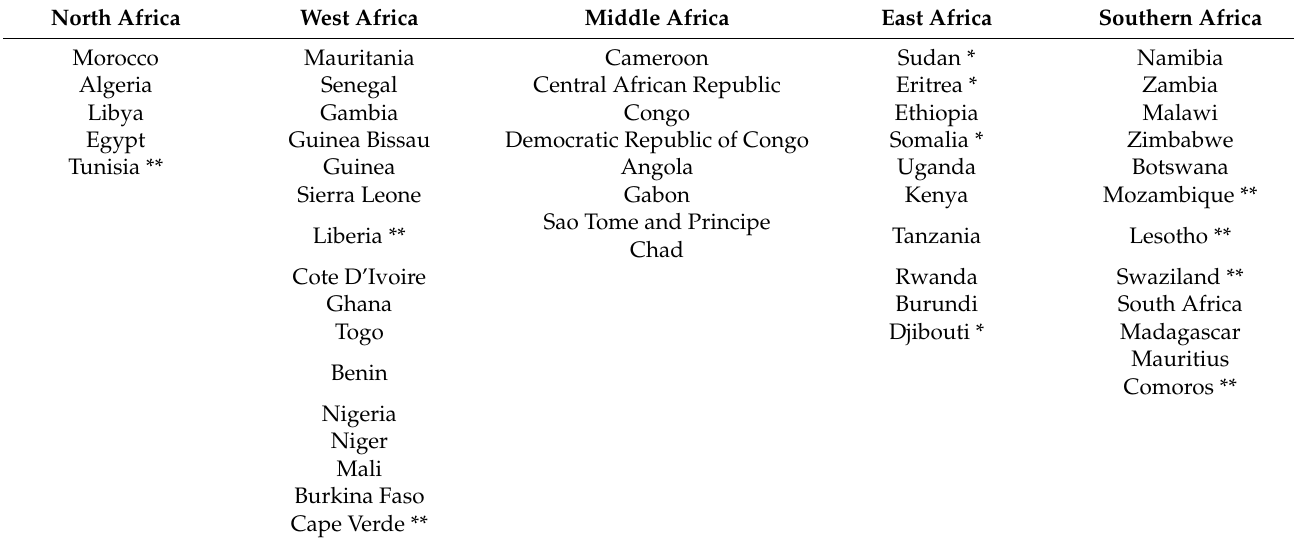
Table 1. Countries included in this